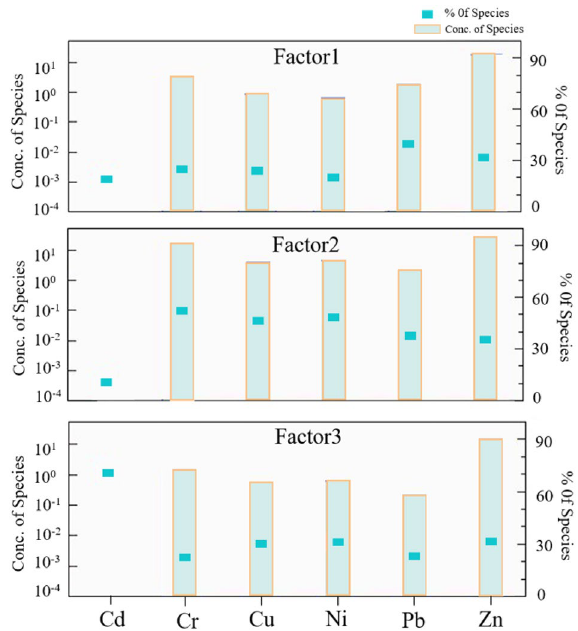
Figure 6. Sources and contributions of HMs in the soil in the PMF